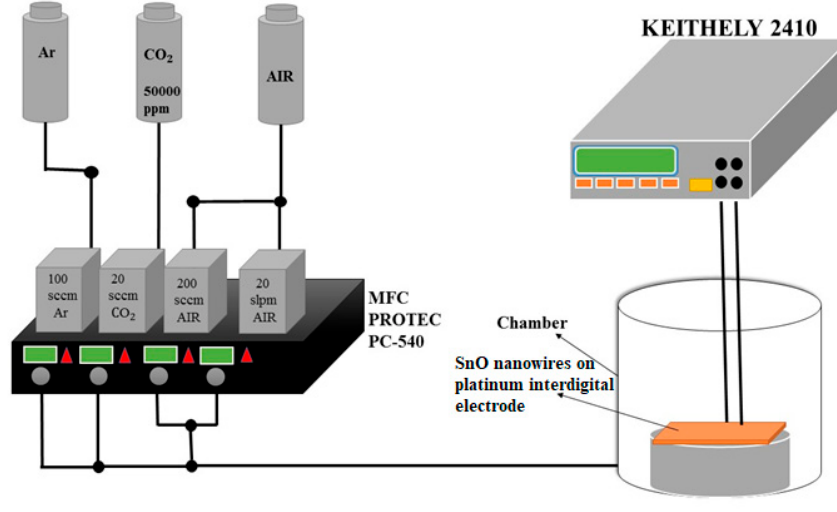
Figure 3. Schematic illustration of a gas sensor.